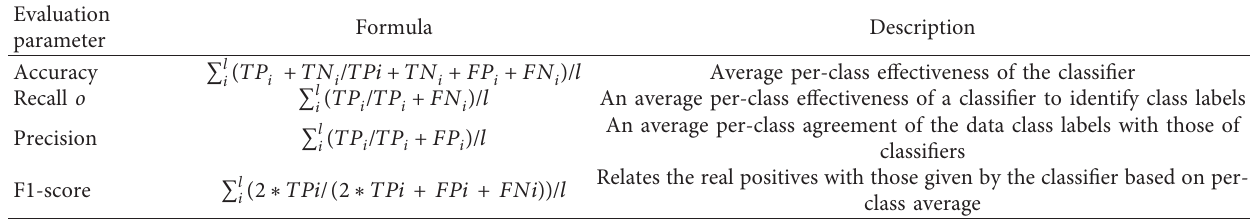
Table 5: Evaluation parameters for the multiclass classification problem.